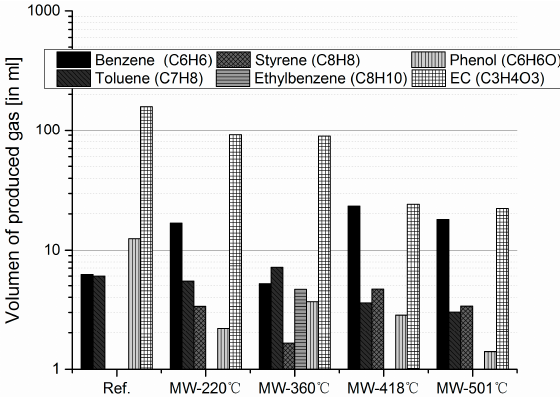
Figure 10. Volume of heavy molecules generated at different target temperatures with microwave heating.